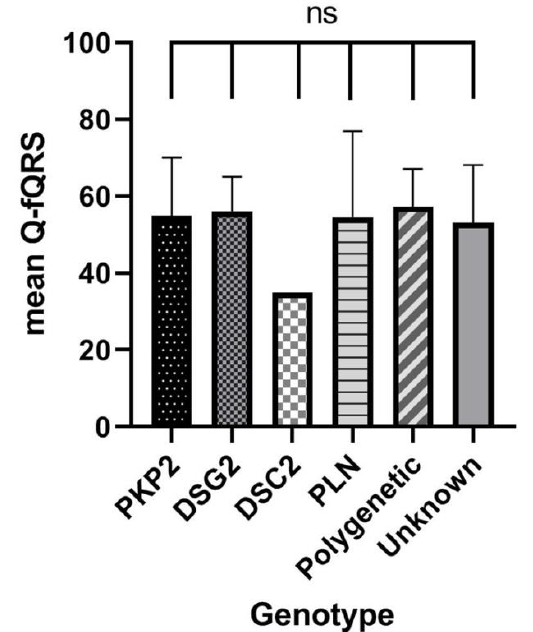
Figure 4. PKP2 = Plakophilin-2; DSG2 = Desmoglein-2; DSC2 = Desmocollin-2; PLN = Phospholamban; Polygenetic = multiple pathogenic ACM-related variants, Unknown = no pathogenic variant identified using genetic screening.